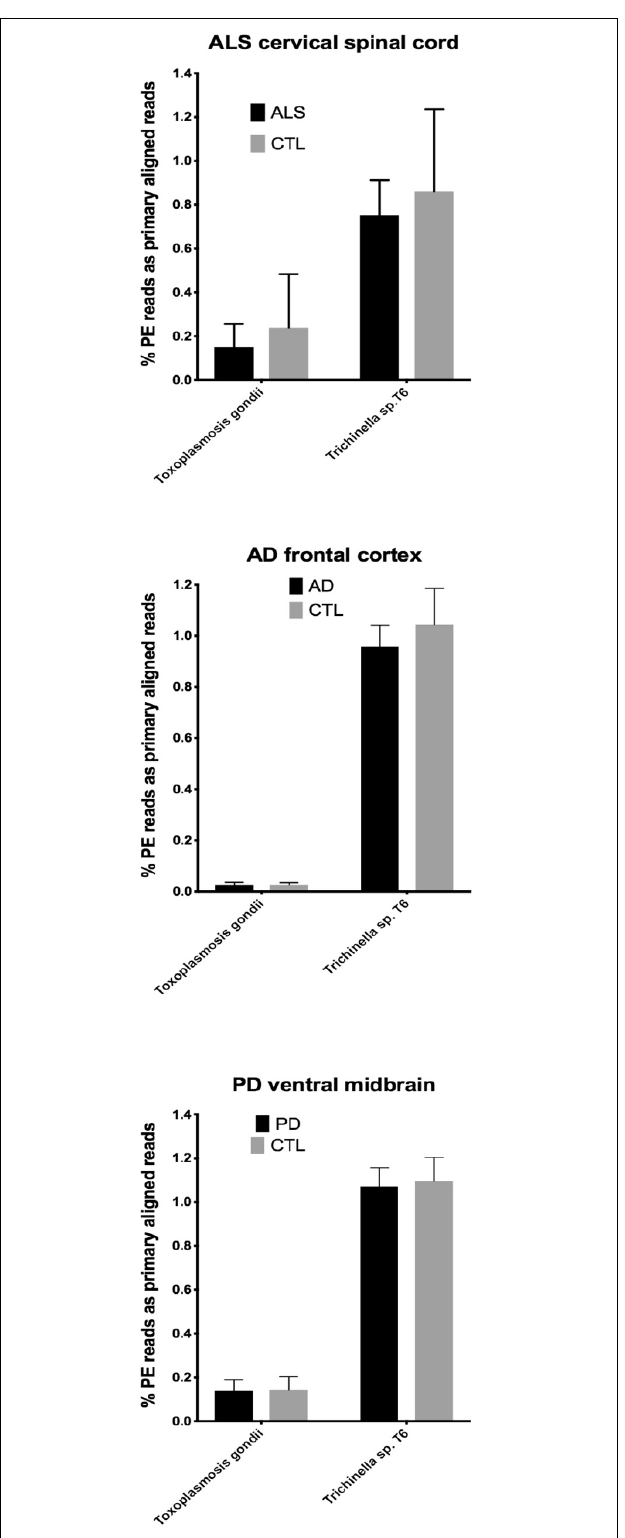
FIGURE 1 | Bar charts of % of total PE reads that aligned in Bowtie2 to the genomes of Babesia microti , Borrelia burgdorferi , Porphyromonas gingivalis , and Treponema denticola . Shown are mean % +SD.